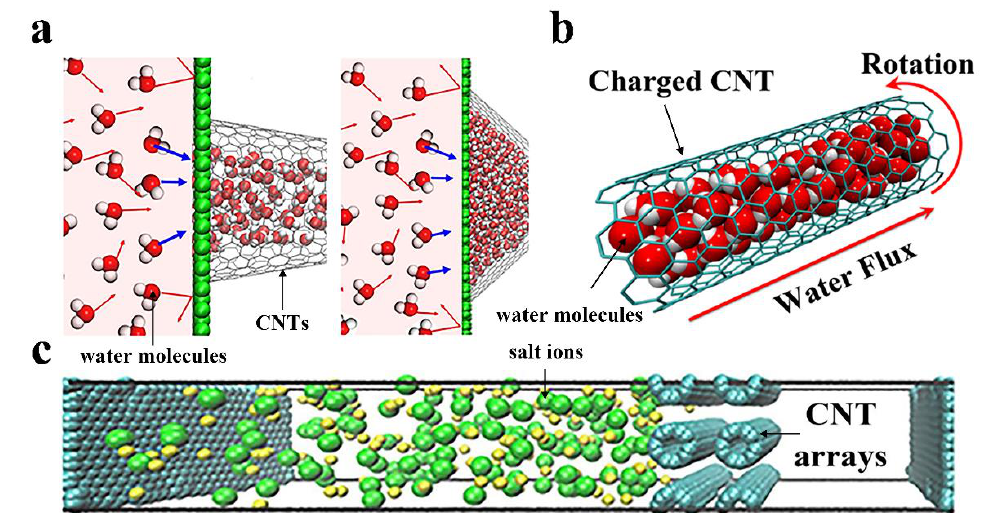
Figure 4. Characteristics a ff ecting the water flow rate of CNTs. ( a ) Cartoon representation of the channel architecture e ff ects on water permeation. CNT channels with 19.2 ◦ apex angles at left and 38.9 ◦ at right. The water molecules in the channels and at the left of the channels represent the real simulation configuration and schematic diagram, respectively (Reproduced or adapted from ref. [37], with permission from Elsevier, 2017); ( b ) diagram of the directed water transportation in rotating charged CNTs (reproduced or adapted from ref. [36], with permission from American Chemical Society, 2017); ( c ) The illustration of the CNT arrays as multilayer transverse flow membrane for desalination (Reproduced or adapted from ref. [81], with permission from Elsevier, 2019).